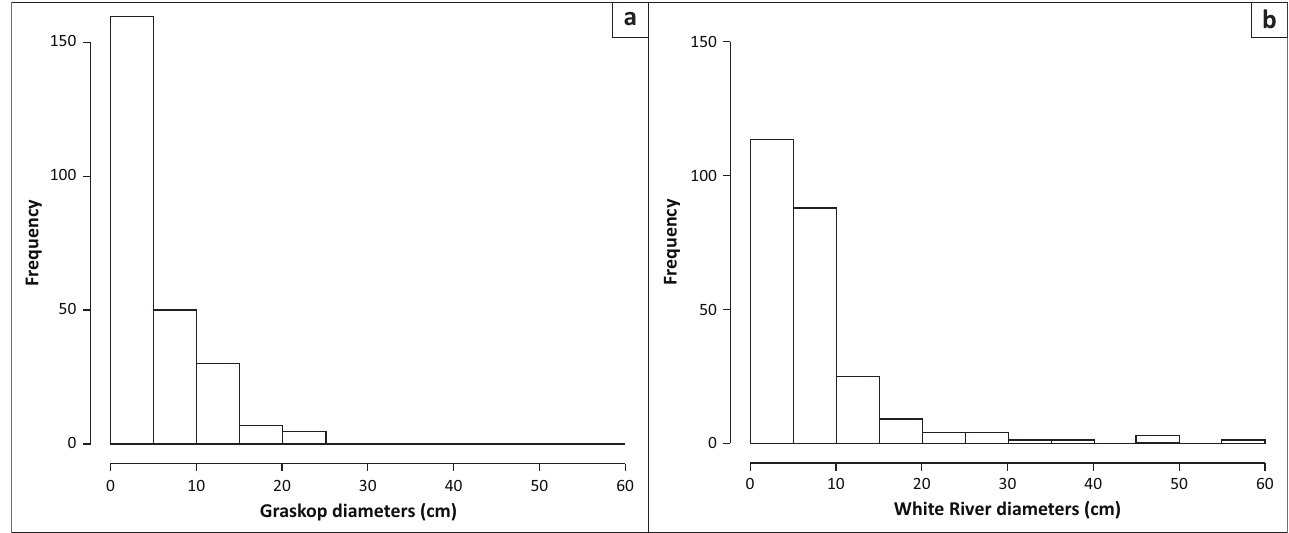
FIGURE 5: Diameter size class distributions of all the populations in (a) Graskop and (b) White River.